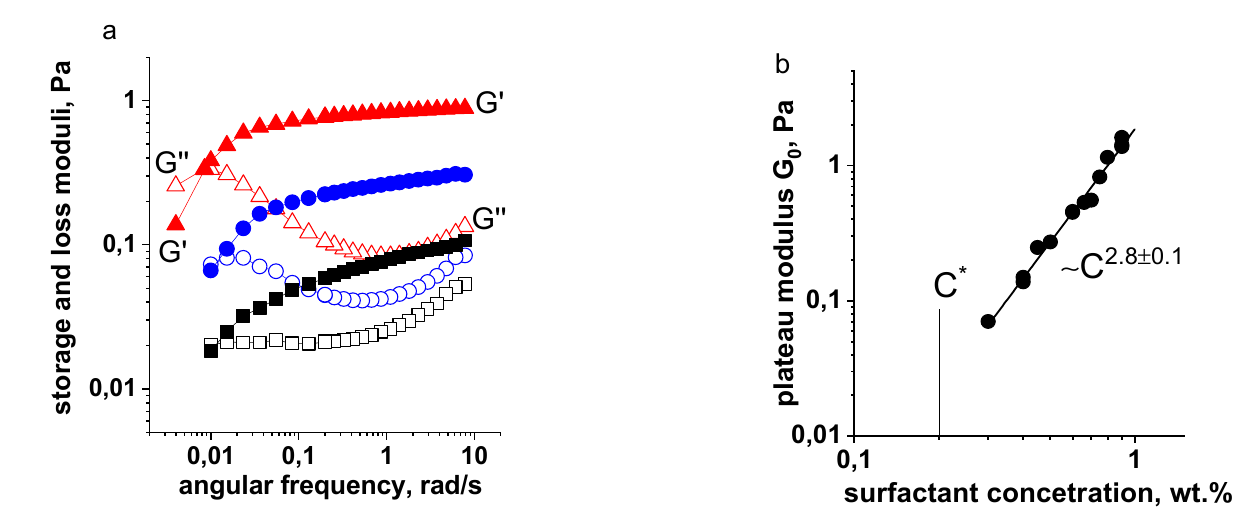
Figure 5. ( a ) Frequency dependencies of storage G (cid:48) (filled symbols) and loss G (cid:48)(cid:48) (open symbols) moduli for aqueous solutions containing 0.3 wt.% (squares), 0.45 wt.% (circles), 0.75 wt.% (triangles) EHAC in the presence of 1.5 wt.% KCl at 25 ◦ C. ( b ) Concentration dependence of plateau modulus and storage modulus at high frequency. The line indicates the overlap concentration C* of WLMs obtained from concentration dependence of zero-shear viscosity.